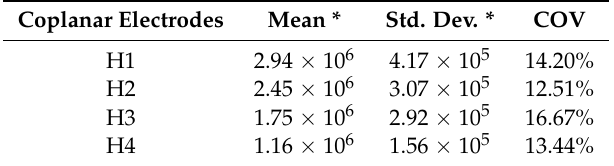
* Units for Mean and Standard Deviation in Ω